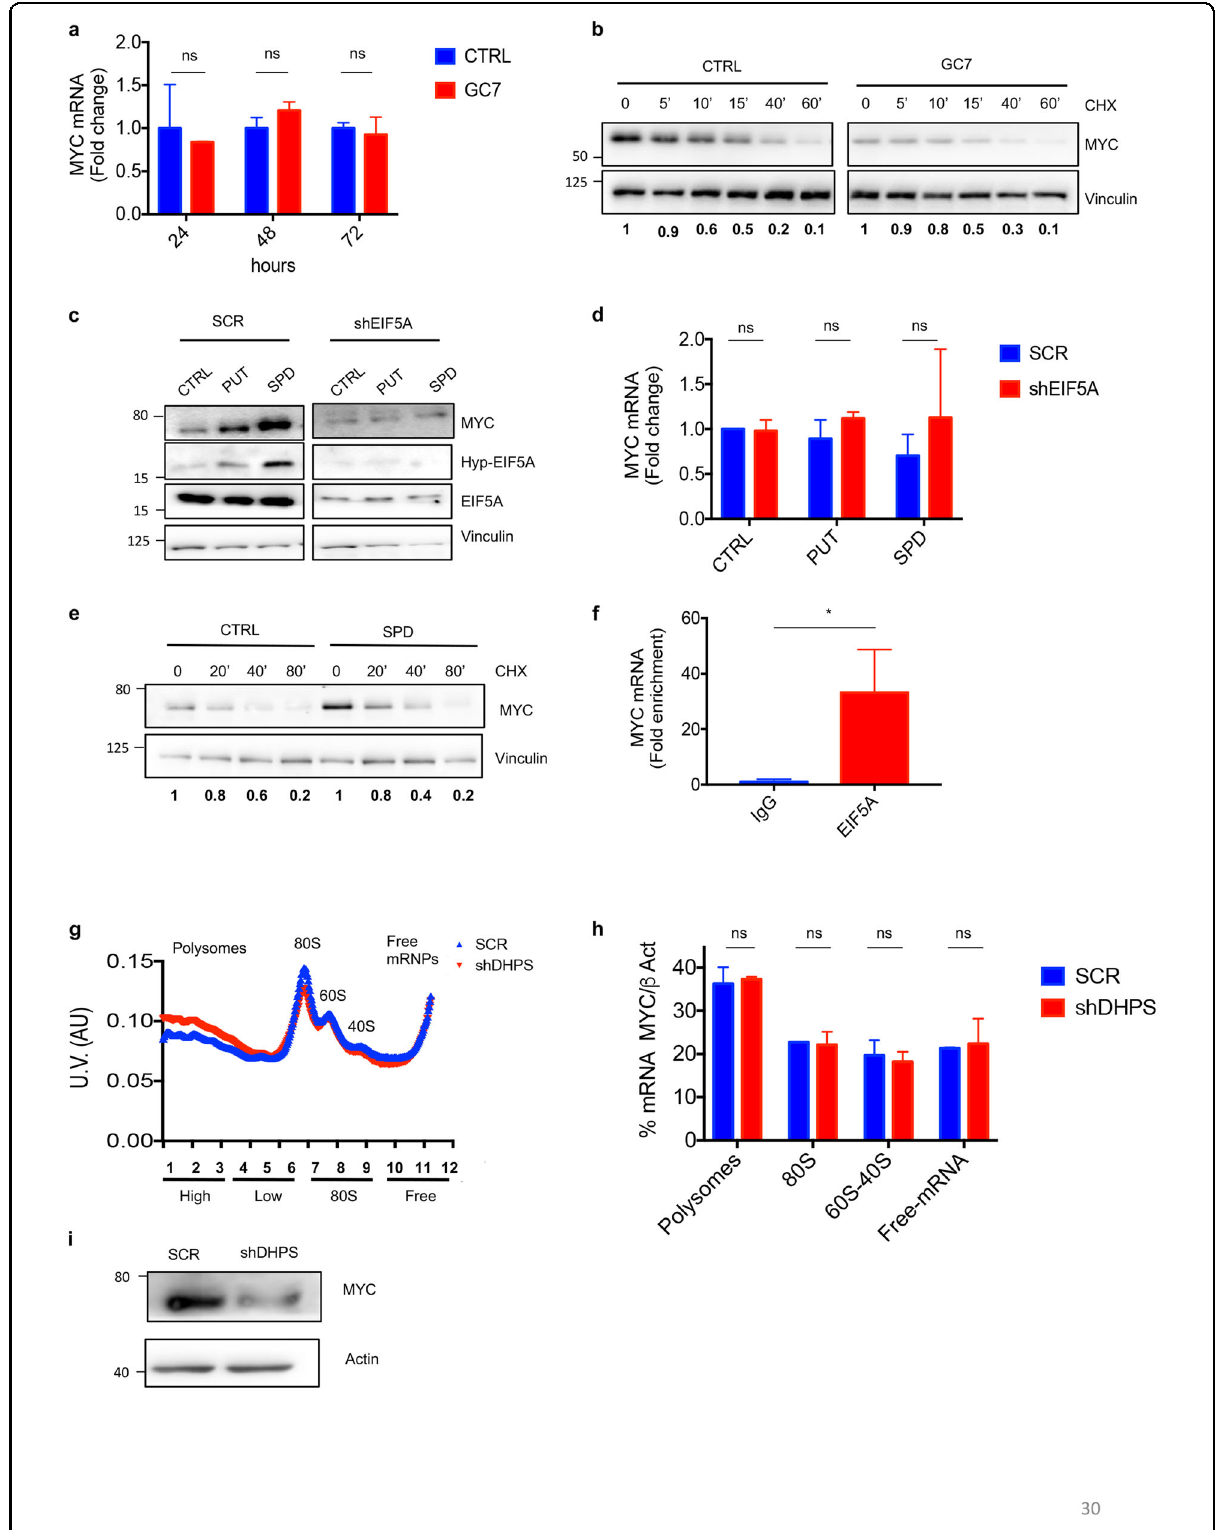
Fig. 3 (See legend on next